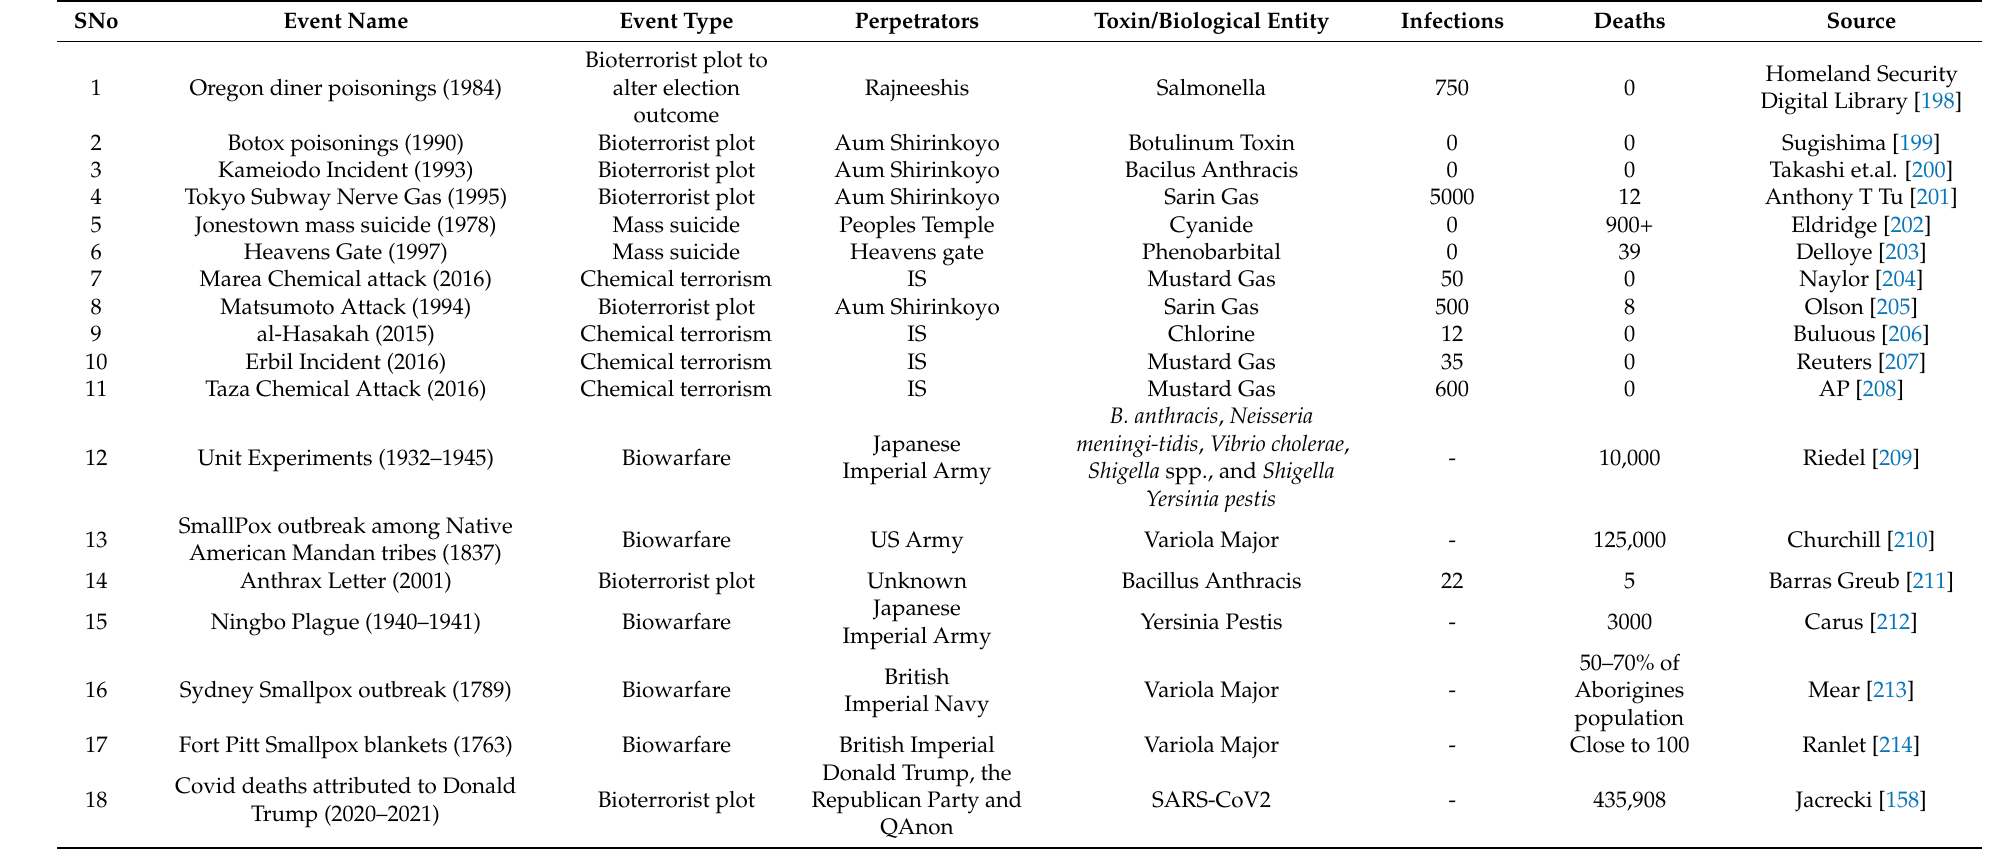
Table 2. A comparison of various biological and chemical terrorist events, including mass suicides orchestrated by various cults andterrorist outfits and comparing them with the Covid-19 infections resulting from Trump Rallies and QAnon